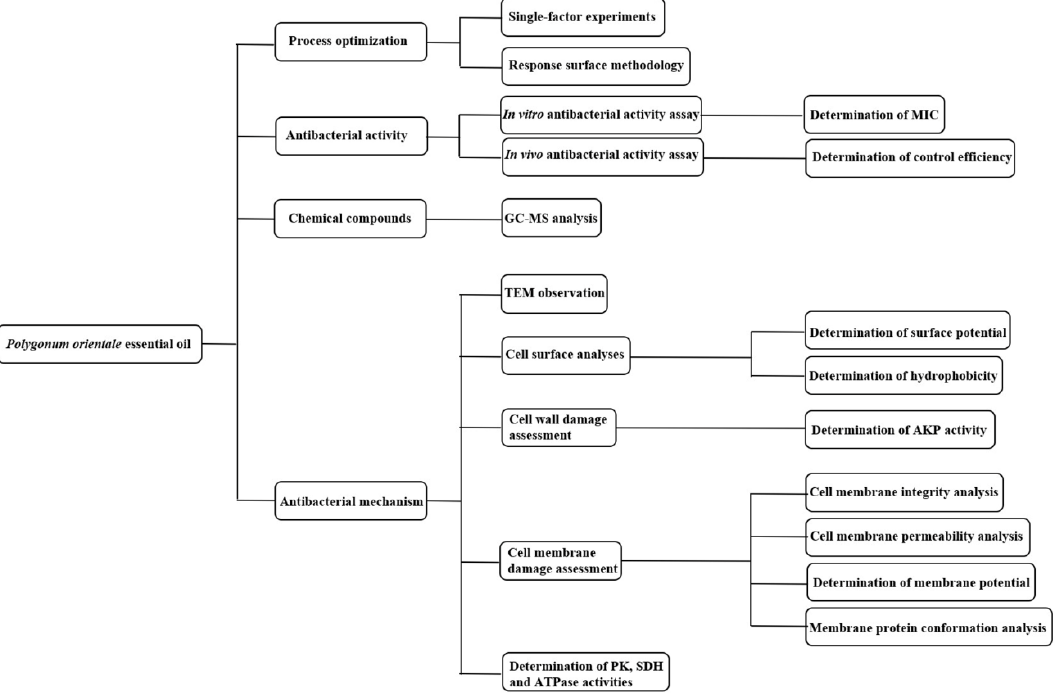
Figure 1. The flowchart of all experiment processes in this study. MIC: minimum inhibitory concentration. GC-MS: gas chromatography–mass spectrometer. TEM: transmission electron microscope. AKP: alkaline phosphatase. PK: pyruvate kinase. SDH: succinate dehydrogenase. ATPase: adenosine triphosphate.